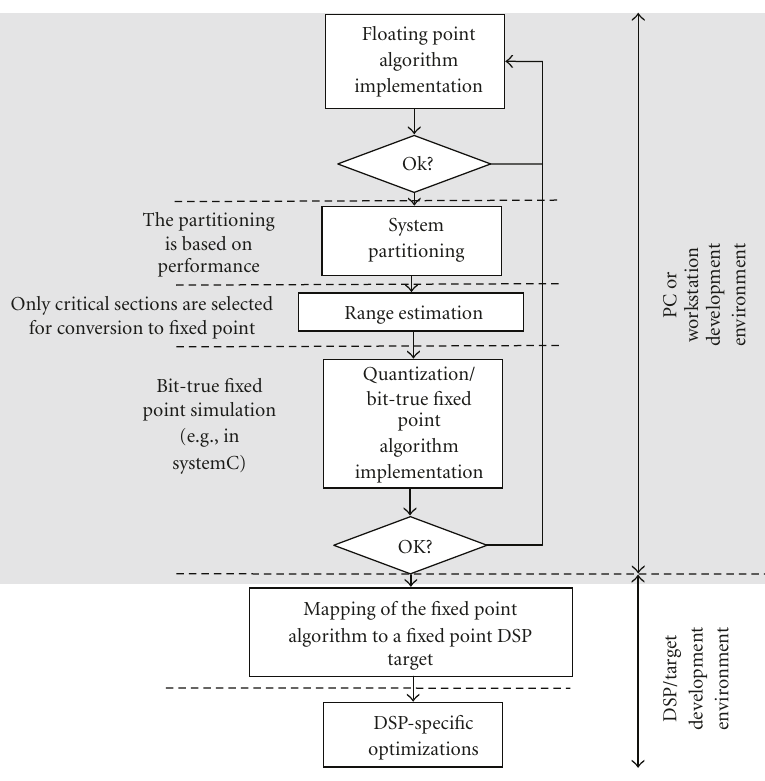
Figure 4: Fixed point design